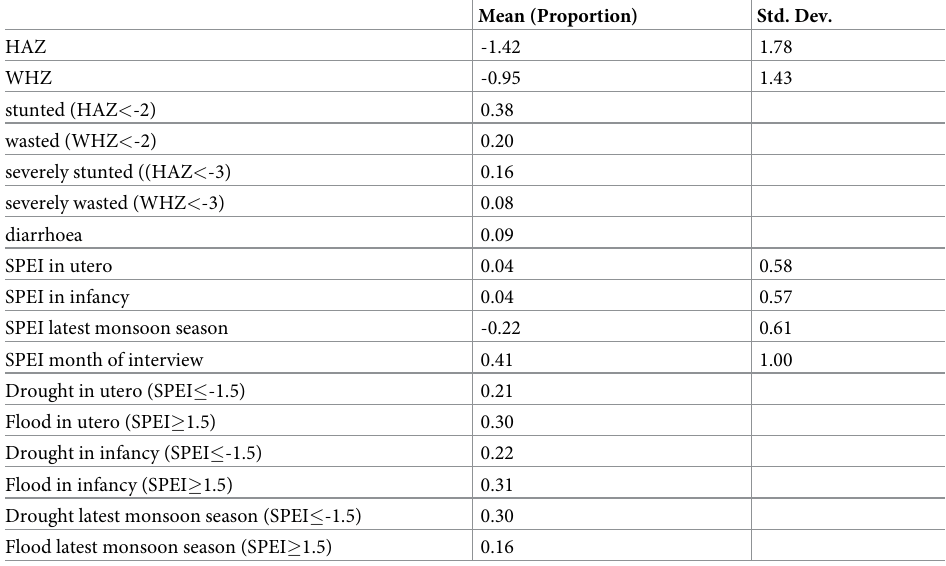
Table 2. Descriptive statistics for main variables of interest.